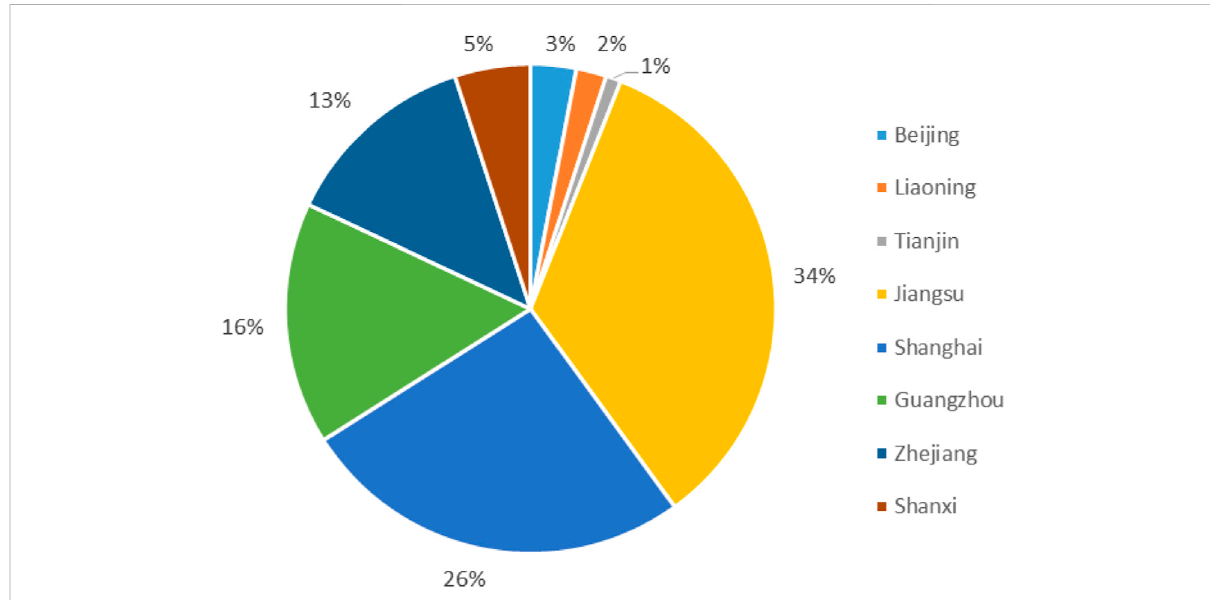
FIGURE 7 Pie chart of helium consumption in China in 2020 (Source: General Administration of Customs) (Li et al.,